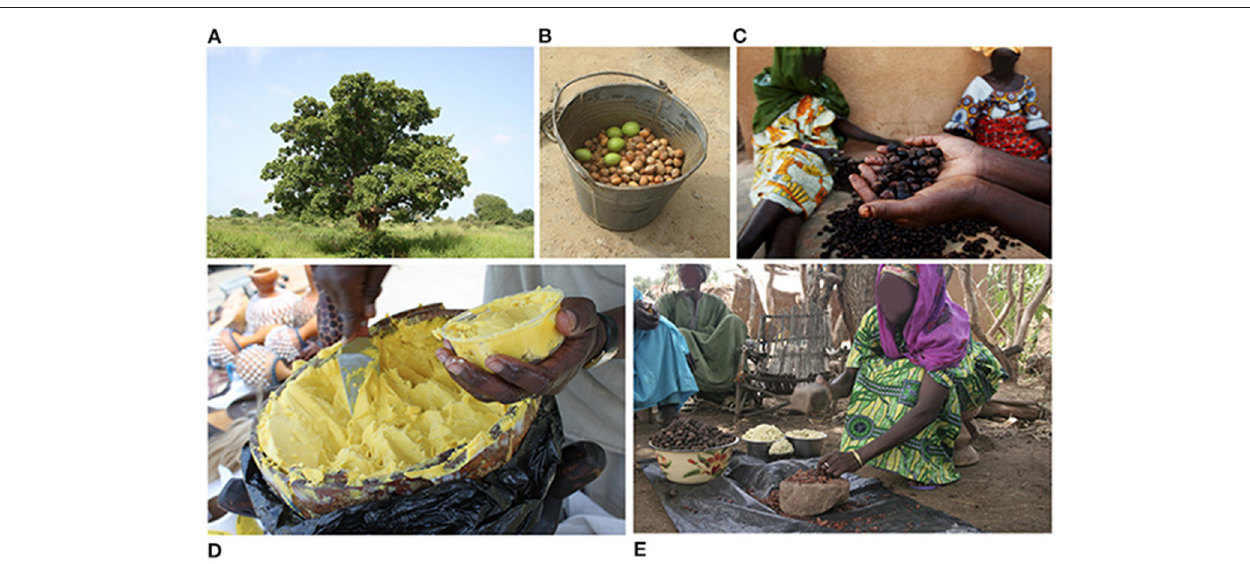
FIGURE 7 | Images of shea (Vitellaria paradoxa) growth and processing from Africa. (A) Vitellaria sp. tree in Burkina Faso. Source: M. Schmidt. CC BY-SA 3.0. (B) Shea nuts and some unripe shea fruits collected in Ghana. Source: F. Khron. CC BY-NC-SA 2.0. (C) Shea nuts. Source: U.S. Government Works. (D) Processed shea butter. Source: Daveynin. CC BY 2.0. (E) Women processing shea nuts into shea butter in Burkina Faso. Source: TREEAID. CC BY